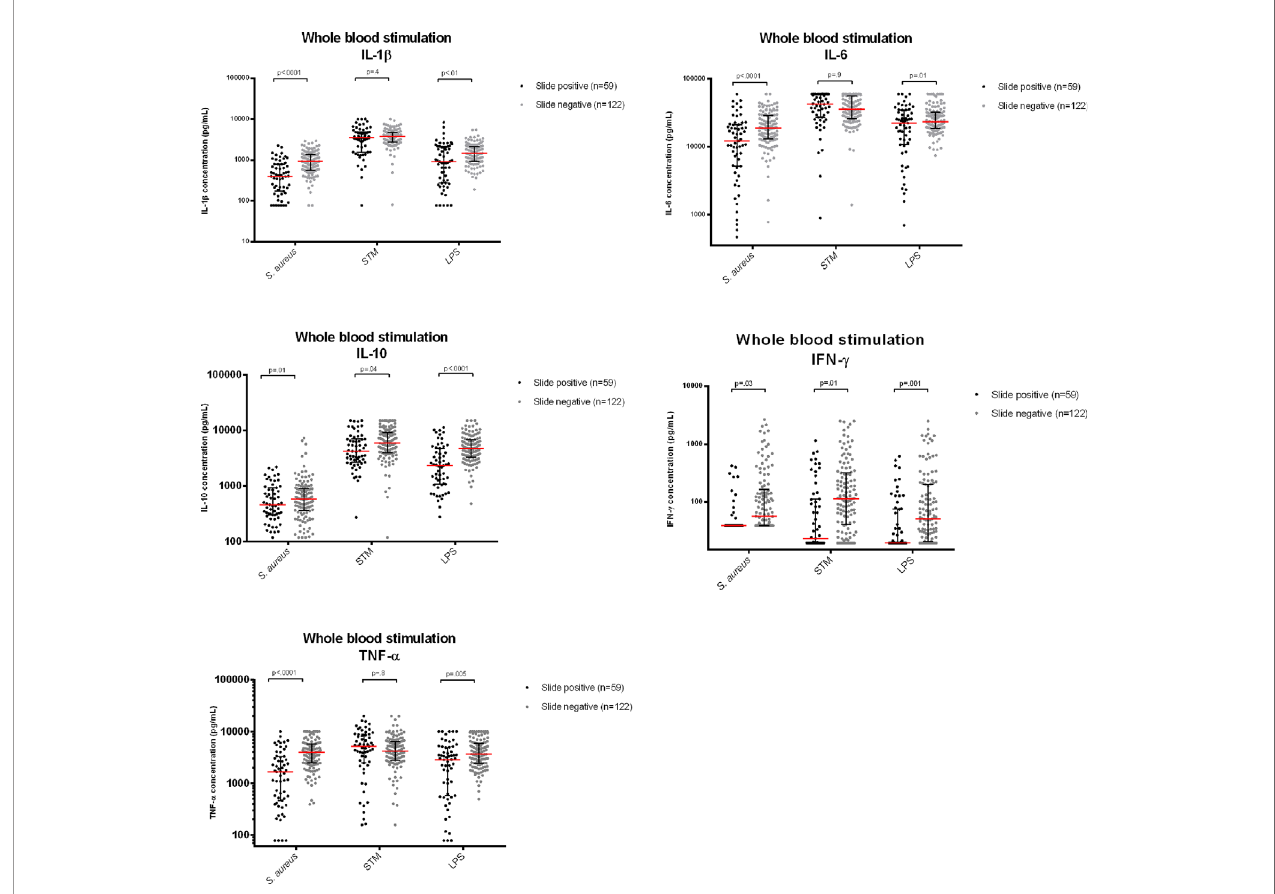
FIGURE 4 | Cytokine concentrations measured in supernatants after whole blood stimulation with Staphylococcus aureus , Salmonella Typhimurium (STM) and Escherichia coli LPS (LPS), comparing participants with asymptomatic Malaria with thick fi lm negative healthy controls. Legend | Cytokine concentrations reported in pg/mL. For comparison, cytokine concentrations were log-converted. P-values corrected for multiple testing using a Bonferroni test.